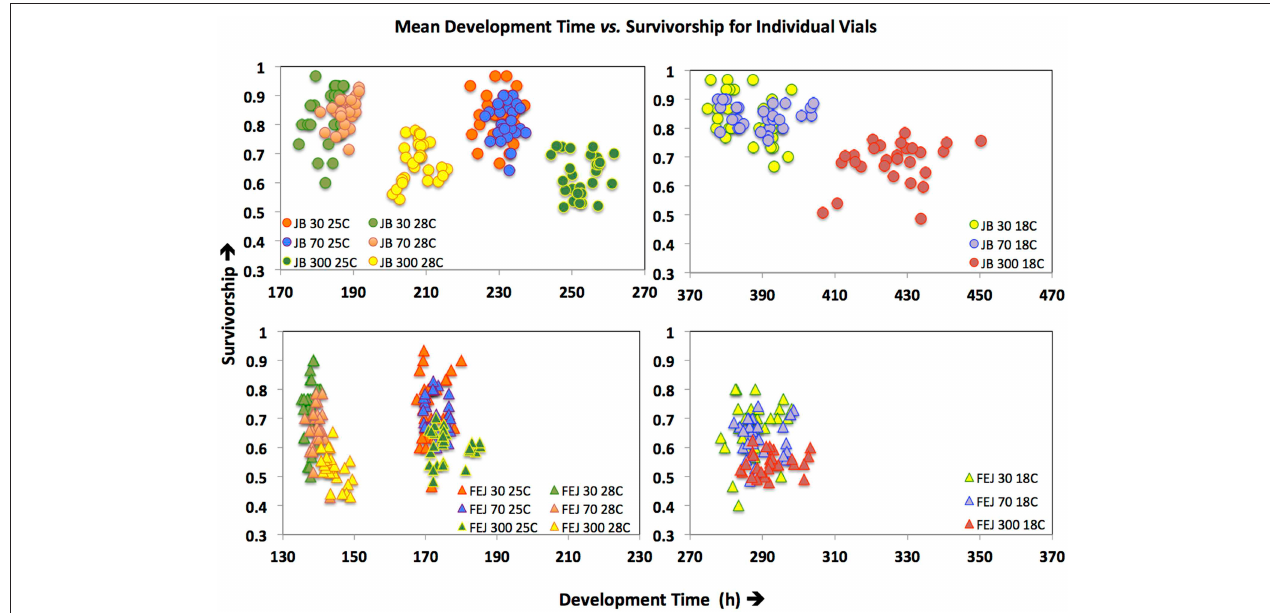
FIGURE 6 | Plot of vial values of survivorship (y-axis) vs. vial mean values of development time (x-axis) for FEJ and JB populations across all treatments. Each circle, or triangle, represents value or mean obtained from one vial.